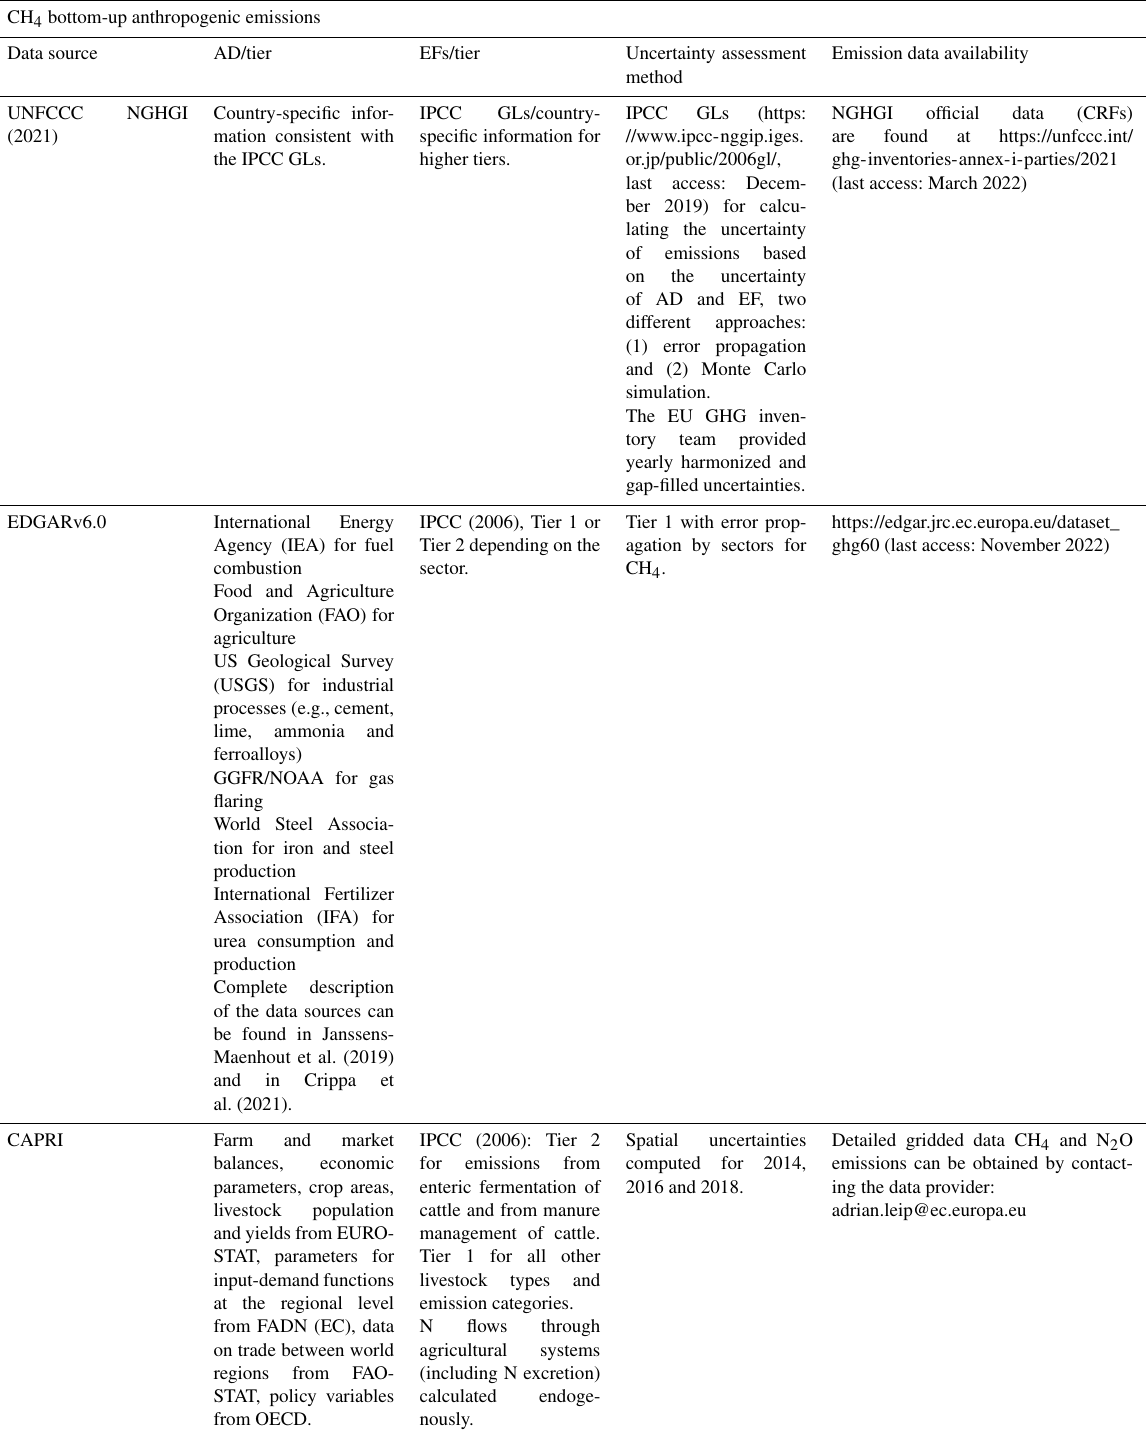
Table B1. Source-specific activity data (AD), emission factors (EF) and uncertainty methodology for the current VERIFY and non-VERIFY 2021 data product